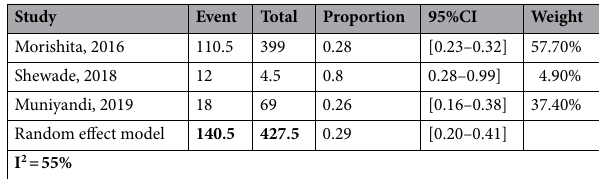
Table 7. Pooled proportion of direct to total costs at catastrophic costs of 20% among active case